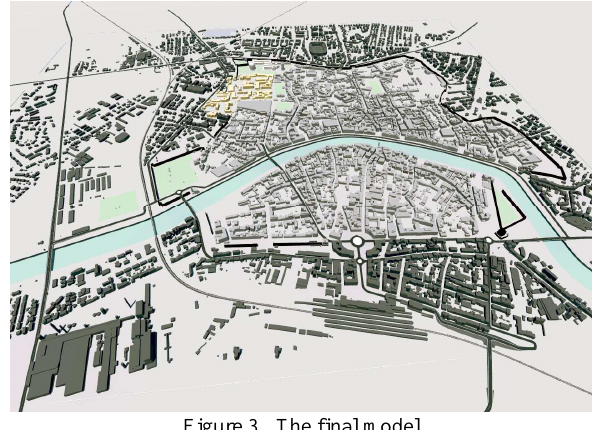
Figure 3. The final